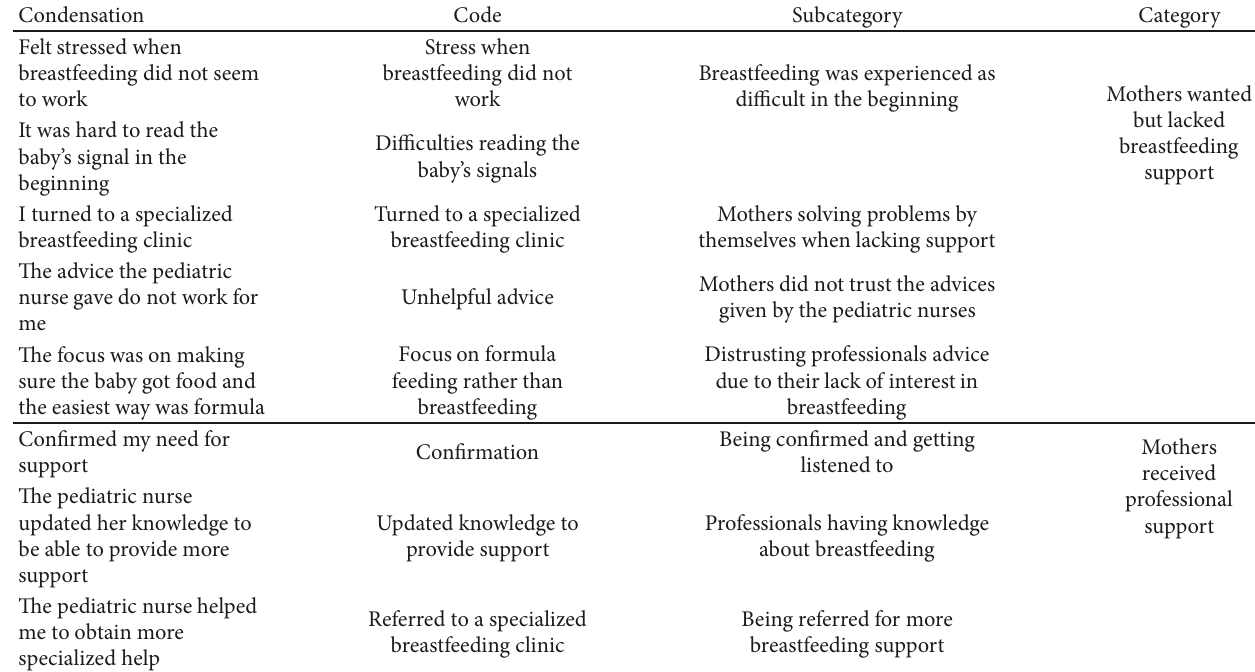
Table 1: Examples of condensation, code, subcategory, and category.